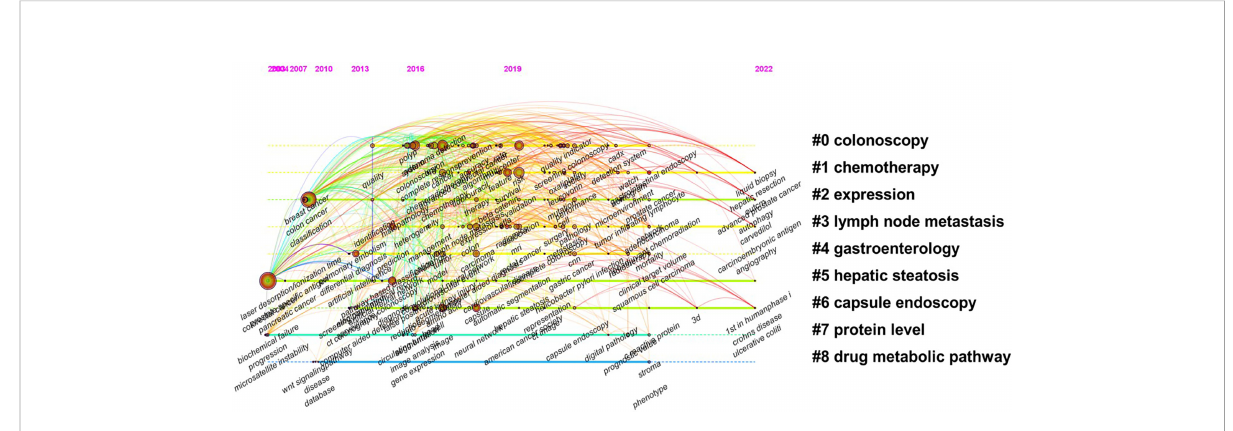
FIGURE 9 Co-citation timeline of references in studies on AI in colorectal cancer.